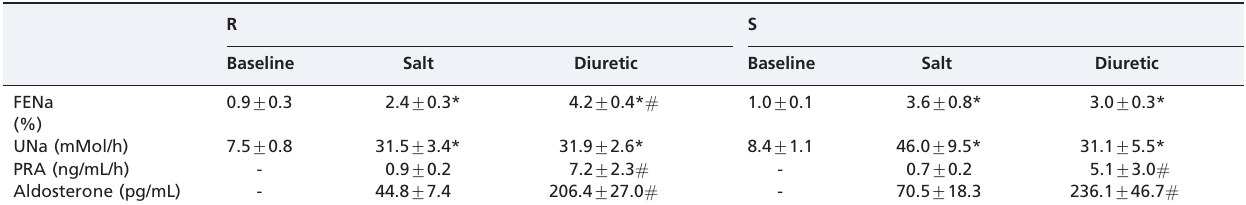
Table 2 - Behavior of fractional excretion of sodium (FENa%), urinary sodium excretion (UNa, mMol/h), plasma renin activity (PRA, ng/ml/h) and plasma aldosterone (pg/mL) during acute sodium loading and depletion. Data are reported as means ¡ SEM.